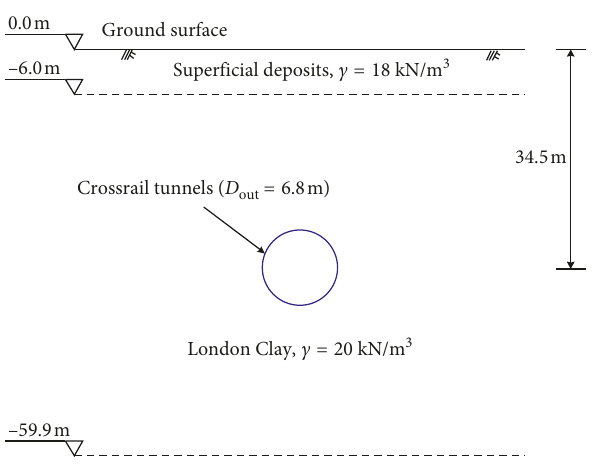
Figure 5: Grout volume recorded in the case history (created based on